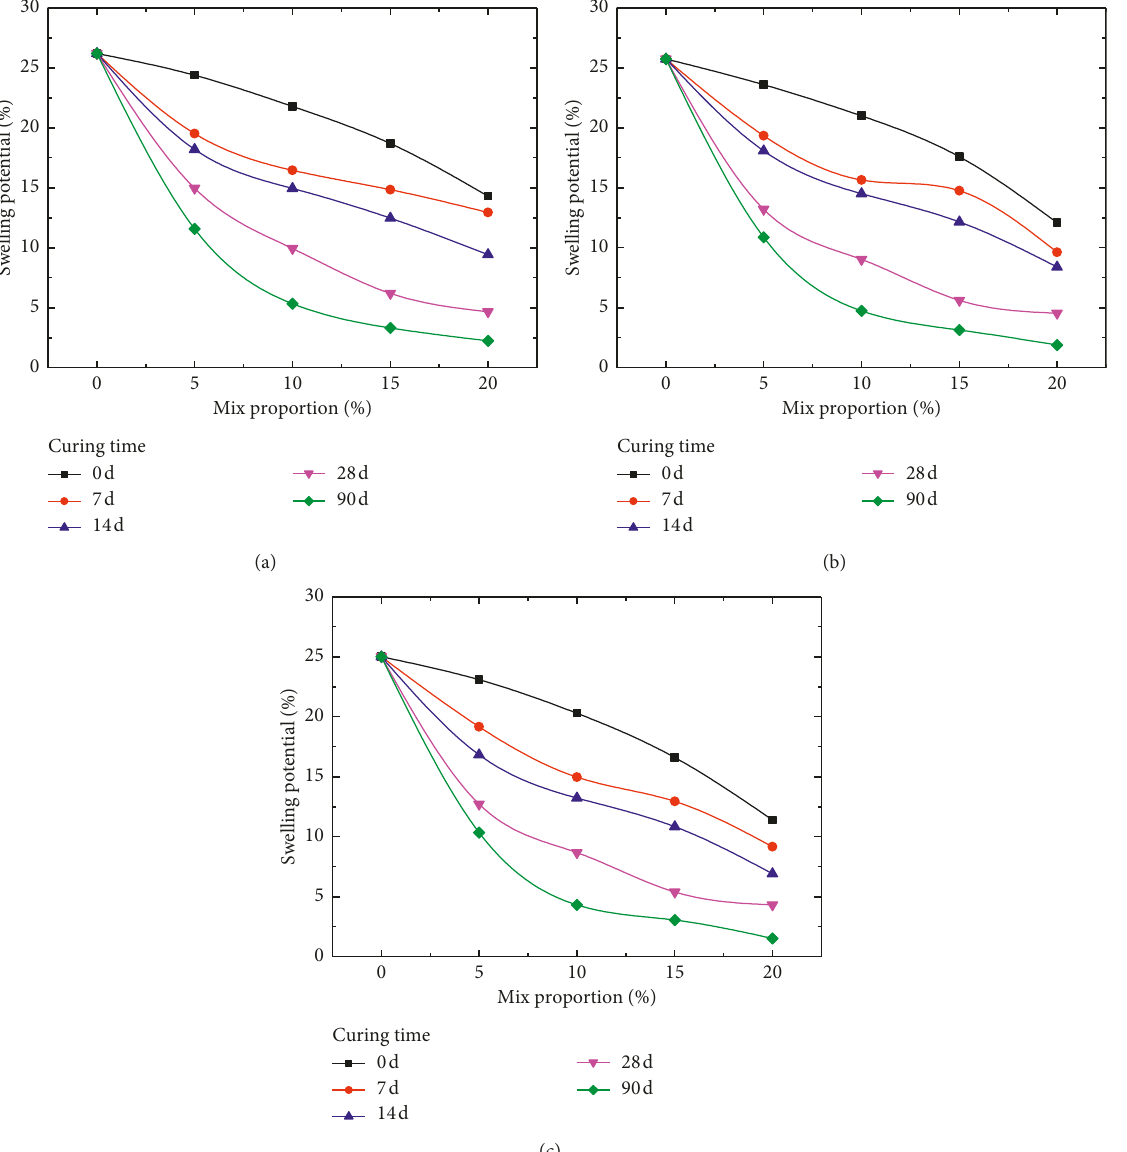
Figure 13: Swelling potential of expansive soil stabilized by RHA-lime. (a) w